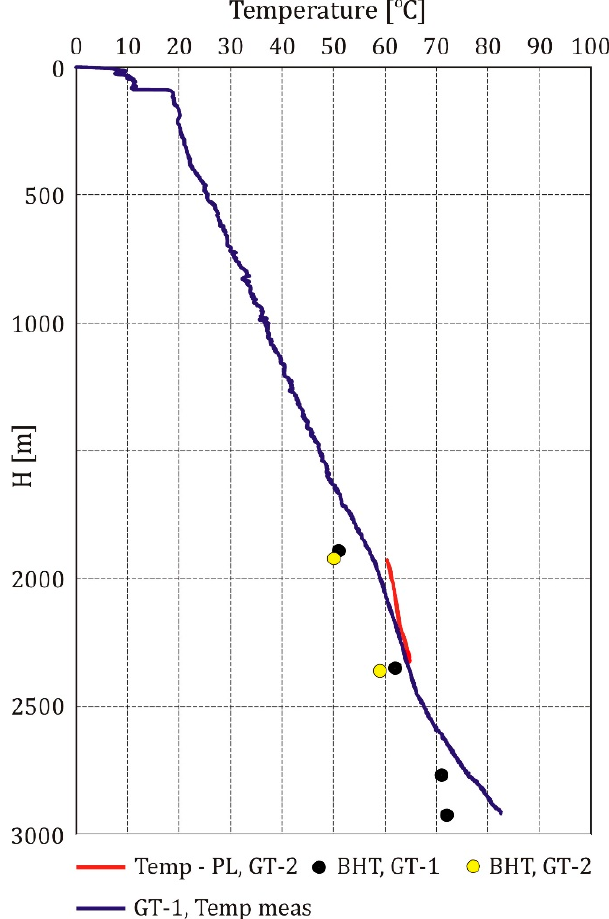
Figure 3. Temperature vs. depth from BHT measurements in GT-1 and GT-2 boreholes, Temp meas log in GT-1 and Production Log result in GT-2.